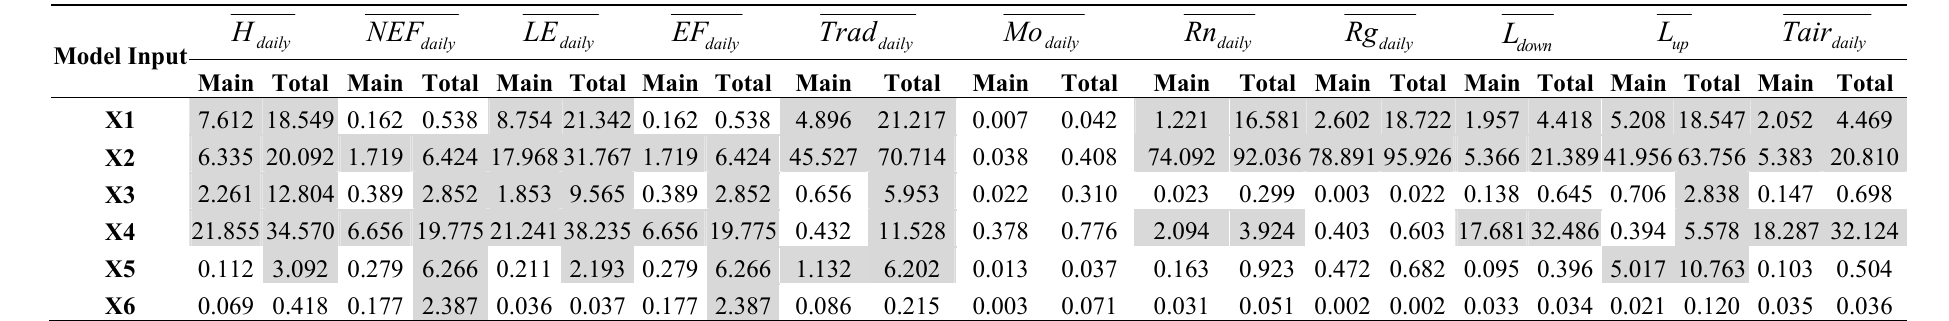
Table 9. Summarised results from the implementation of the BACCO GEM-SA method on the different outputs simulated by SimSphere using uniform PDFs at 17:00. Computed main (Main) and total effect (Total) indices by the GEM tool (expressed as %) for each of the model parameters are shown, whereas the last three lines summarise the percentages of the explained total output variance of the main effects alone (ME), the 1st order interactions only (1st) and the 2nd or higher order interactions only (>1st). Input parameters with a variance decomposition of greater than 1% are